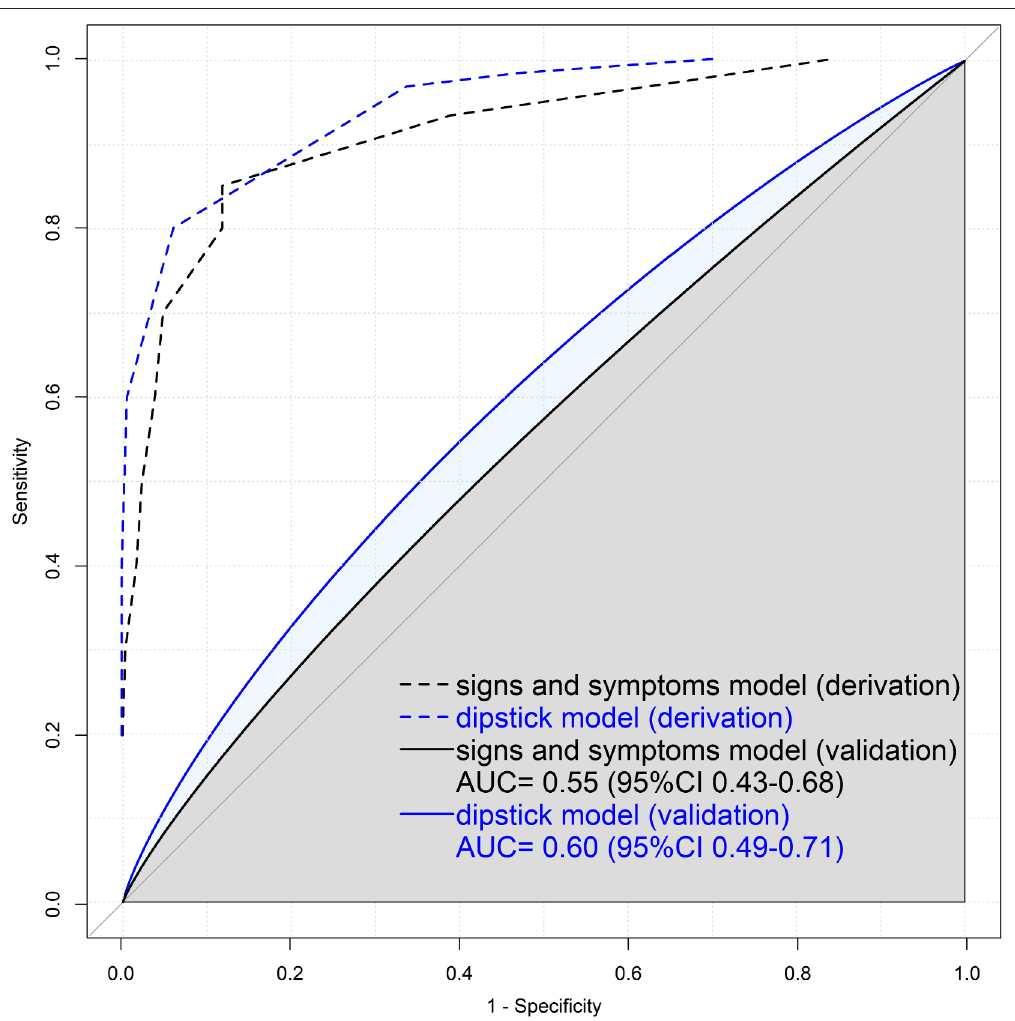
Figure 2 Receiver operating characteristic (ROC) plot of the DUTY coefficient- based model for urinary tract infection in children aged <5 years. ROC plot showing sensitivity versus 1- specificity. The recalibrated intercept and slope were –1.5731 and 0.1473 for the signs and symptoms coefficient- based model and –0.9252 and 0.2526 for the dipstick coefficient- based model, respectively. The calibration was weak for both scores (see Supplementary Figure S1). AUC = area under the ROC